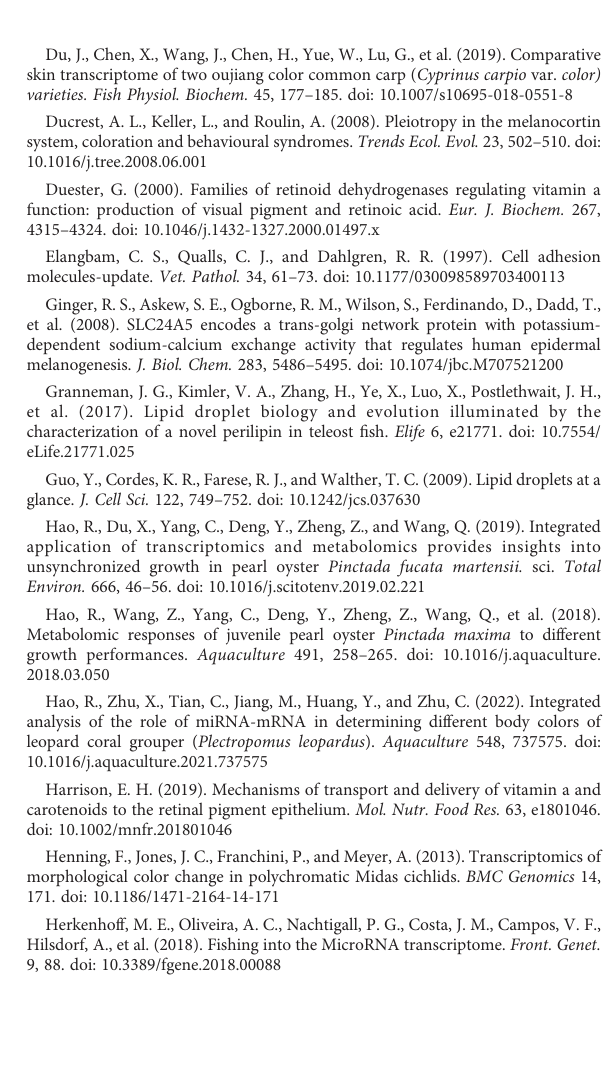
SUPPLEMENTARY FIGURE 3 Derived PCA score plot, derived OPLS-DA score plots, and corresponding validation plots ofOPLS-DA analysis. ZWrepresents thebrown group,and ZR represents the red group. SUPPLEMENTARY FIGURE 4 Pathway enrichmentanalysisofSDMsandintegratedanalysisofDEGsand SDMs (A, B) showed the pathway analysis of SDMs from POS and NEG, respectively. (C) exhibited the integrated analysis of DEGs and SDMs. SUPPLEMENTARY FIGURE 5 Expression validation of miRNA from miRNA transcriptome. SUPPLEMENTARY FIGURE 6 IntegratedanalysisoffucuspathwayCircle,rhombus,andtriangleshowed the DEGs, SDMs and DEMs, respectively. Among them, orange color showed the DEGs, SDMs, and DEMs in the focus pathway. The red and blue line showed the positive and negative correlation among DEGs, SDMs and DEMs,